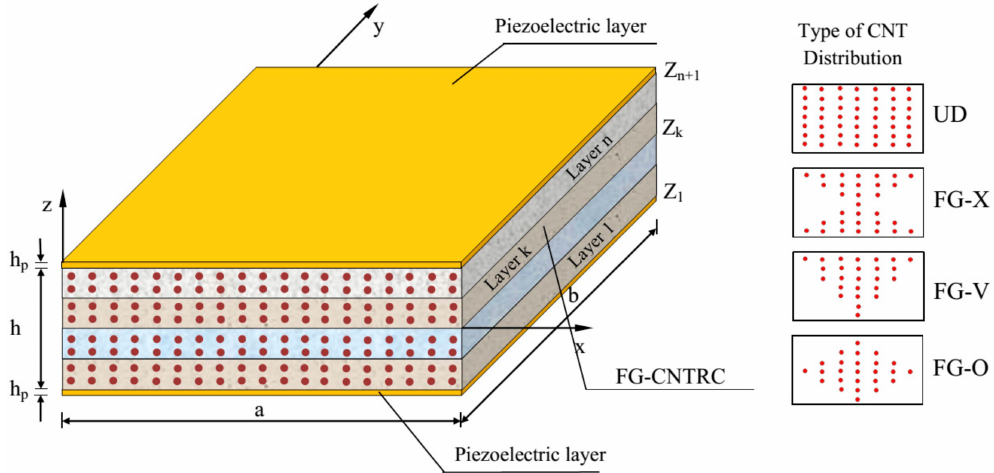
Figure 1. Configuration of the laminated piezoelectric functionally graded carbon nanotube-reinforced composite plates